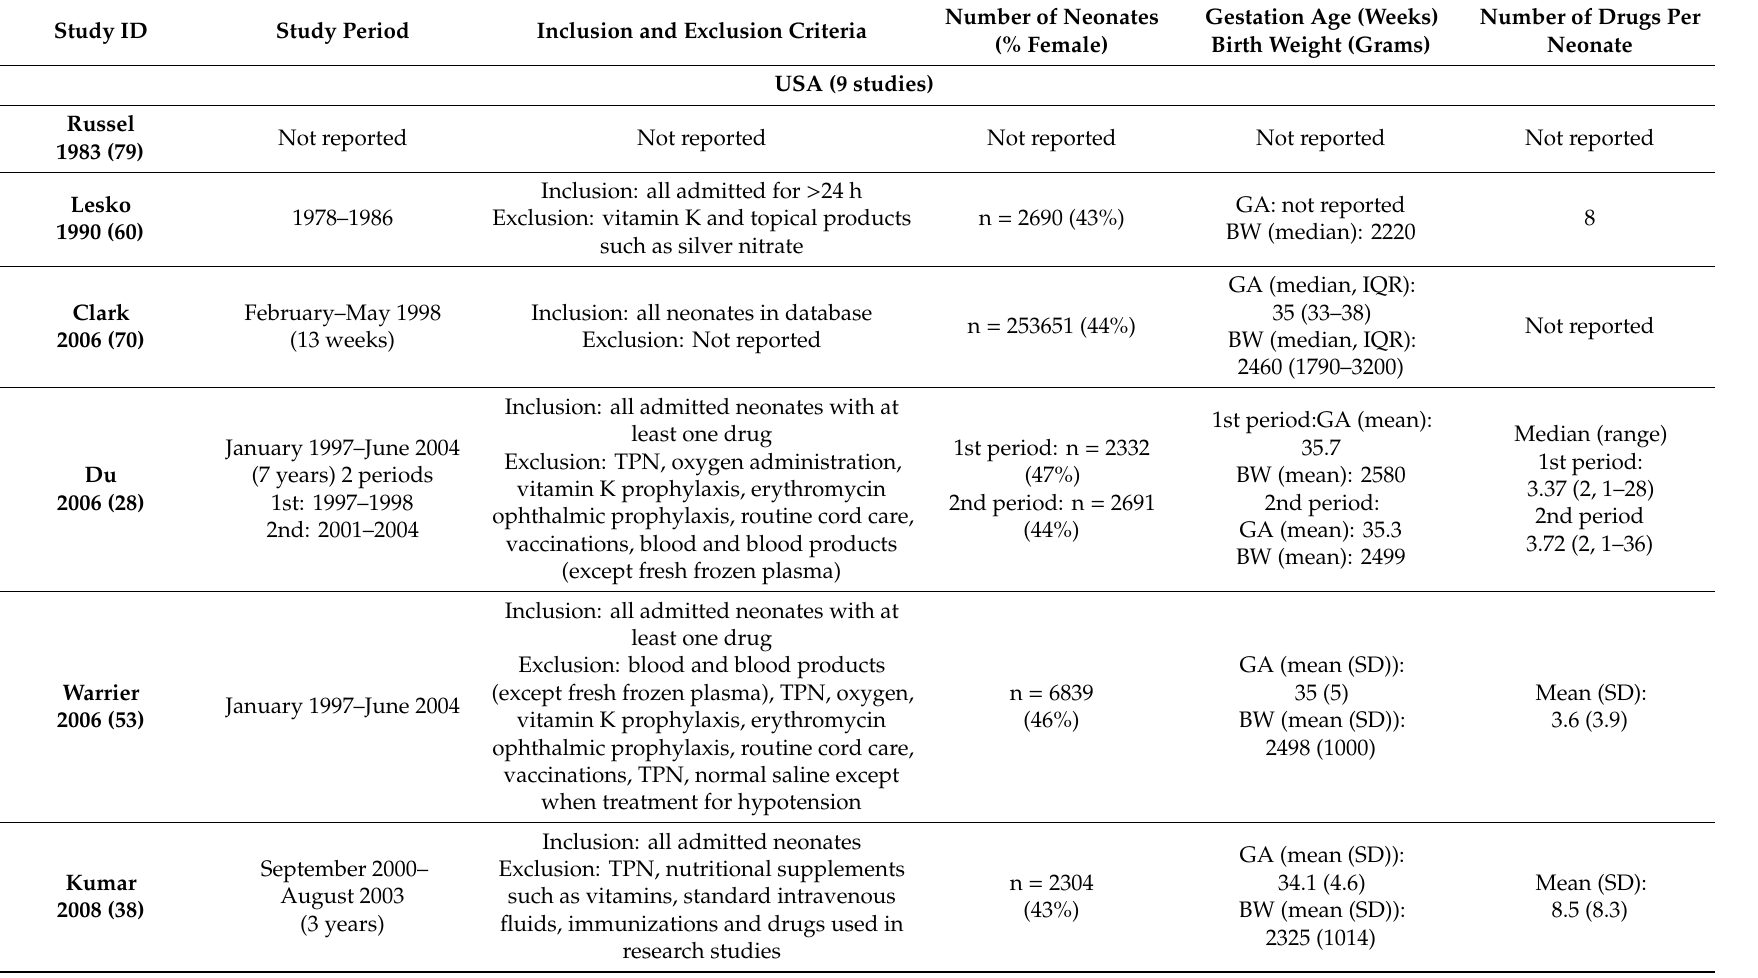
Table A4. Studies of drug utilization in North America (12